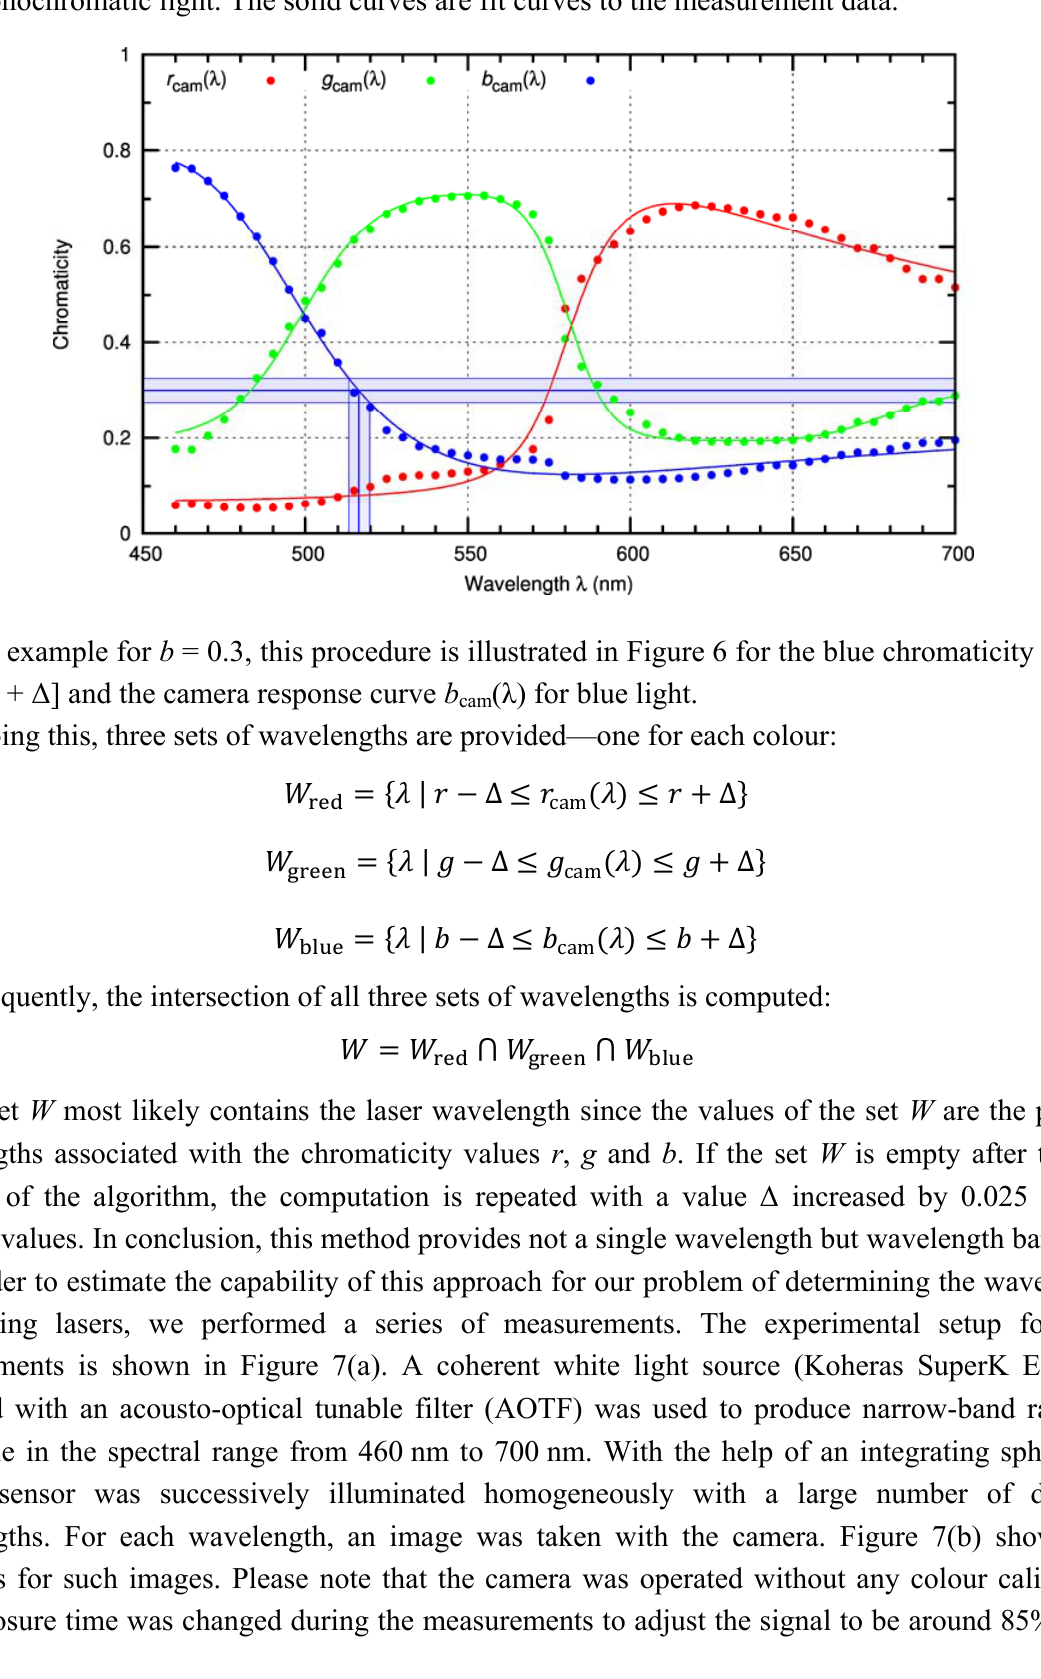
Figure 6. Colour response curves of the camera used in the optical setup (VRmagic VRmC-12 Pro). The dots in the plot show measured chromaticity values for monochromatic light. The solid curves are fit curves to the measurement